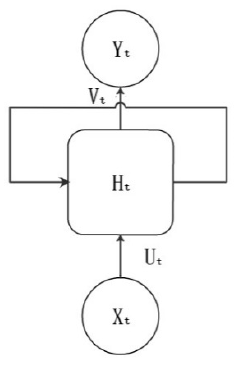
Figure 2. A simple structure of RNN.